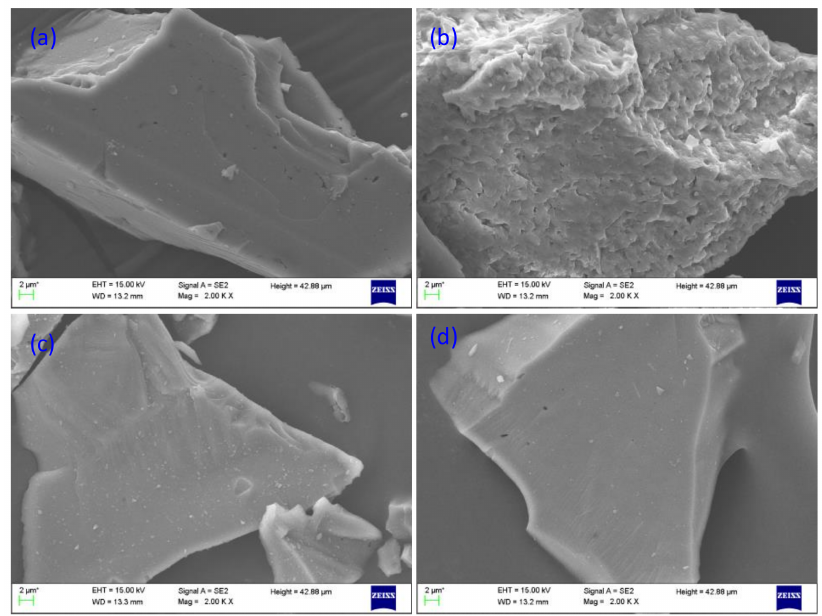
Figure 8. SEM microphotographs of untreated feldspar ( a ), HF pretreated feldspar ( b ), untreated quartz ( c ) and HF pretreated quartz ( d